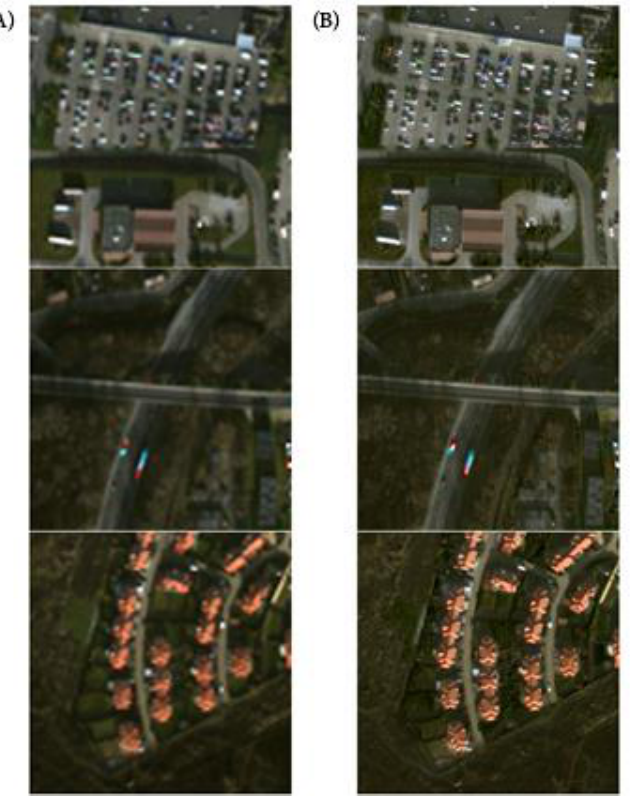
Figure 6. Sample pairs of ( A ) LR and ( B ) HR images that were used to train the ESRGAN network. As a result of the operations described above, a database containing 29,500 LR im- ages with the dimensions of 96 × 96 pixels and corresponding HR images with the di- mensions of 384 × 384 pixels was created.